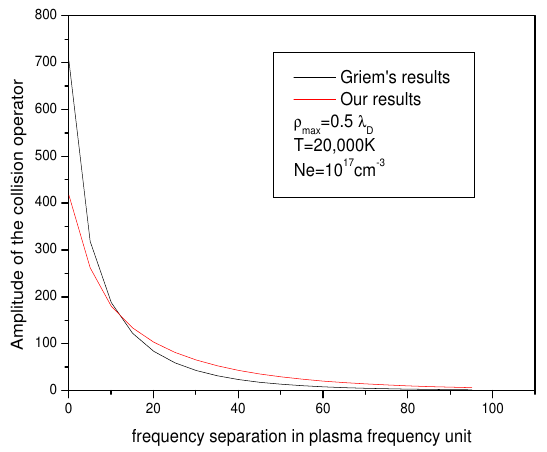
Figure 6. Amplitude of collision operator versus frequency separation in plasma frequency unit ¯ ω αα (cid:48) for Ne = 10 17 cm − 3 and a temperature 20,000 K. The amplitude is in π 2 A /768 unit where A is defined in the text as Equation (26) and ρ max = 0.5 λ D